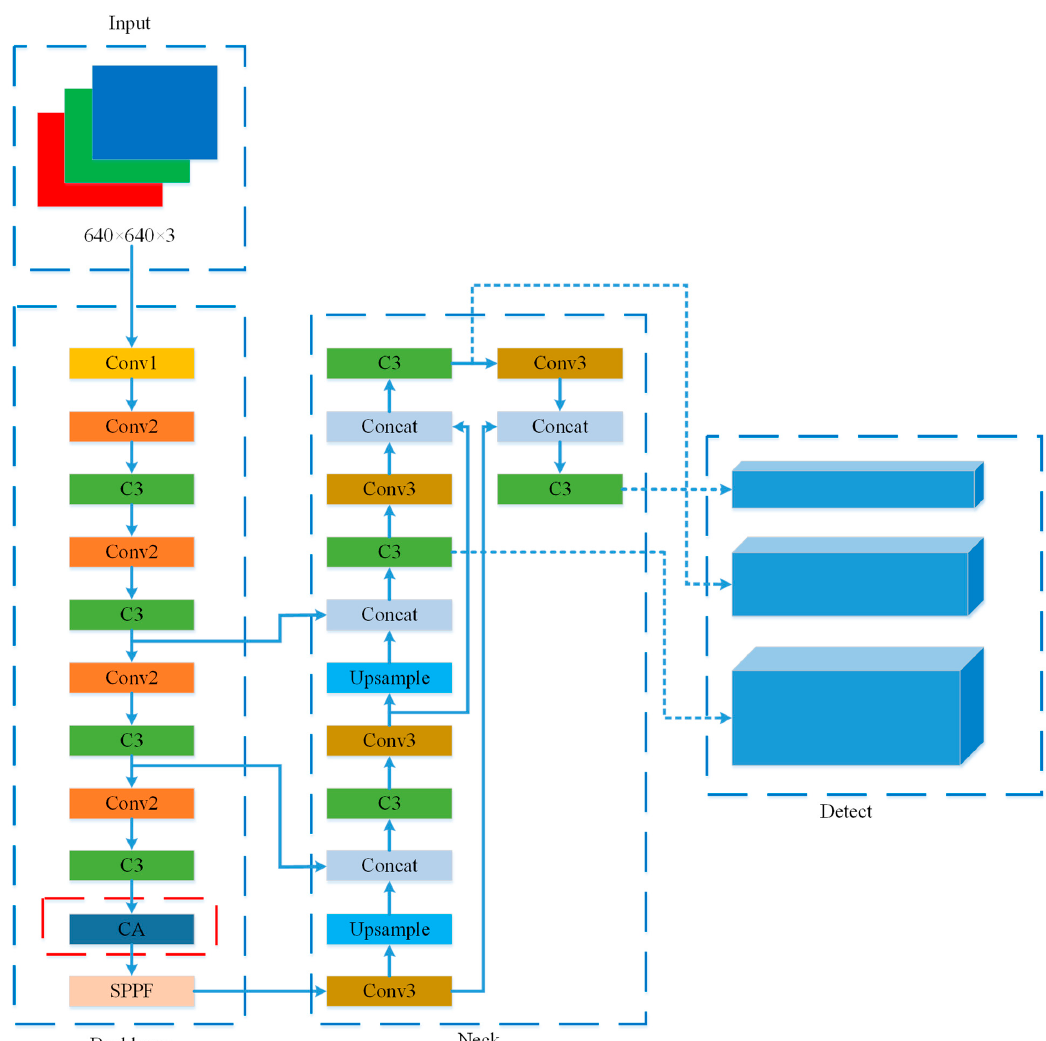
Figure 10. Improved Yolov5 network